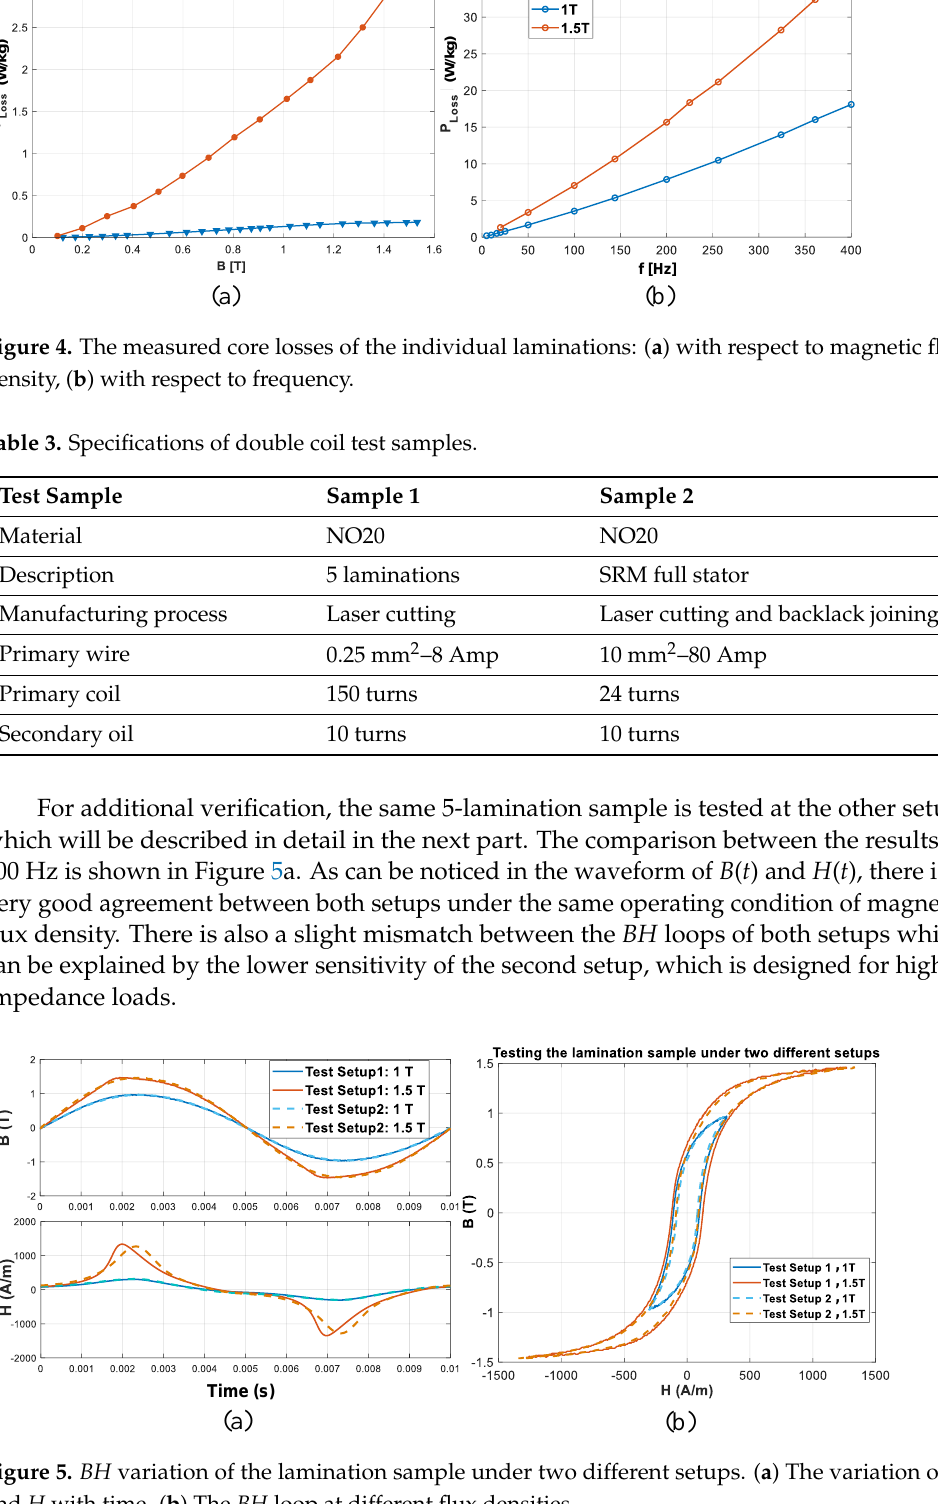
Figure 5. BH variation of the lamination sample under two different setups. ( a ) The variation of B and H with time. ( b ) The BH loop at different flux